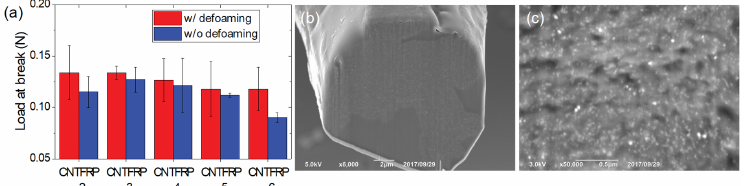
Figure 5. ( a ) Load-at-break value of the composite fibers prepared with defoaming (red) and without defoaming (blue) process. ( b ) Cross-section and ( c ) high-magnification images of CNTFRP-2 without defoaming.